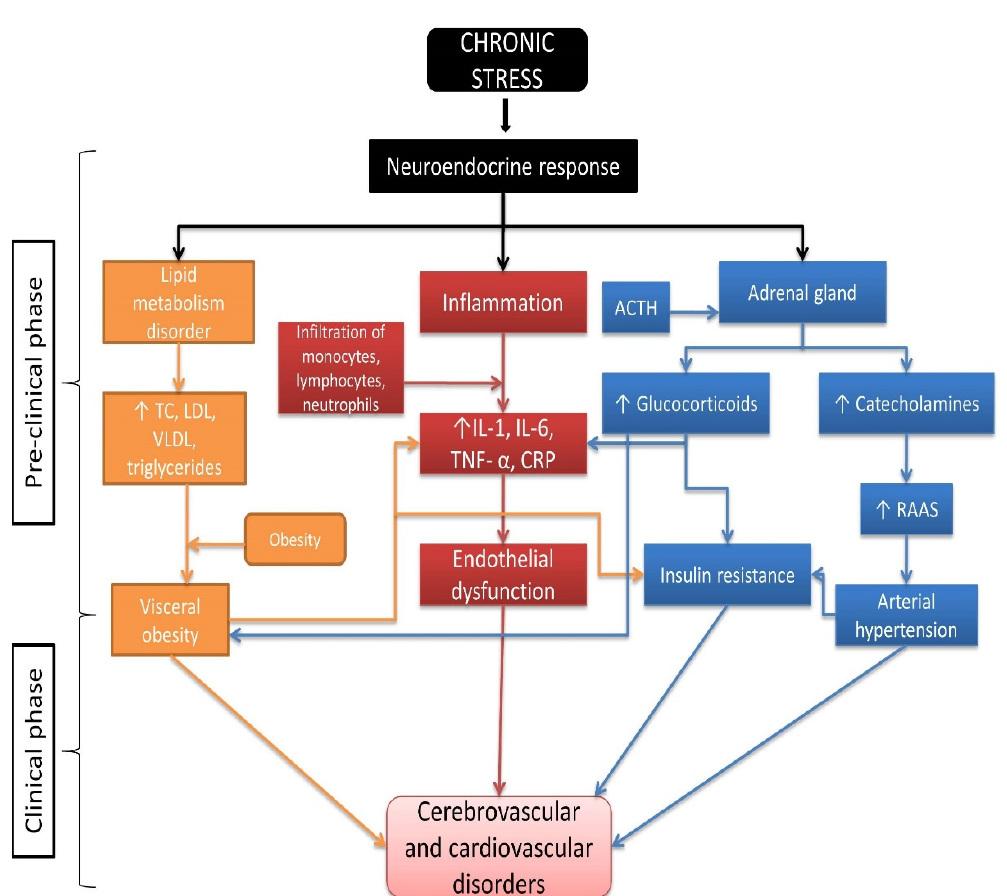
Figure 4. Multifactorial nature of neuroendocrine response in the onset and development of cerebrovascular and cardiovascular diseases. Abbreviations; ACTH—adrenocorticotropin; CRP—C reactive protein; IL-1—interleukin 1; IL-6—interleukin 6; LDL—low-density lipoprotein; RAAS—renin–angiotensin–aldosterone system; TC—total cholesterol; TNF- α —tumour necrosis factor α ; VLDL—very-low-density lipoprotein.